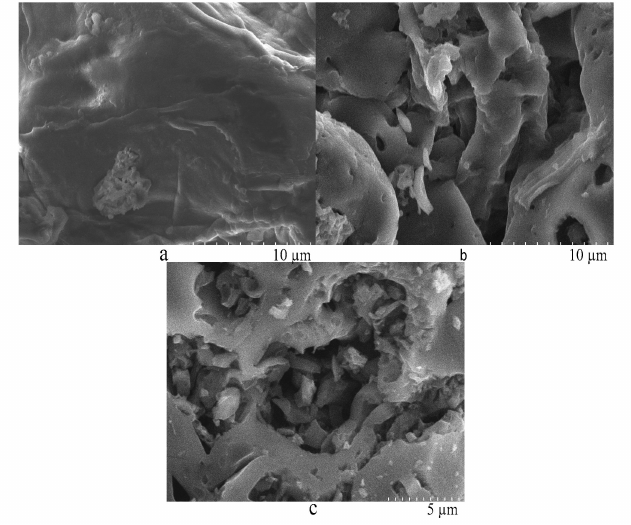
Figure 5. The SEM images of ( a ) coffee grounds, ( b ) carbon precursor, and ( c ) activated